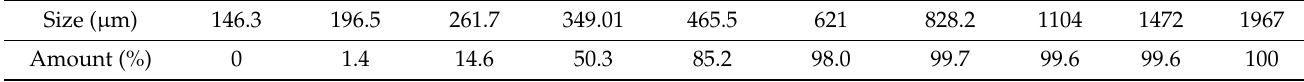
Table 1. The size distribution of the sand